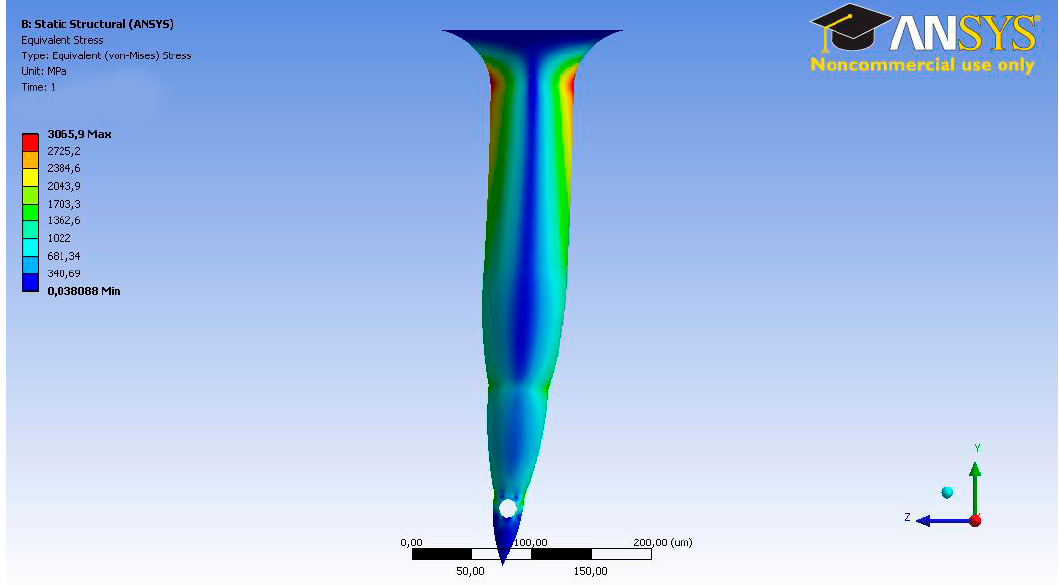
Figure 3. Bee sting microneedle.